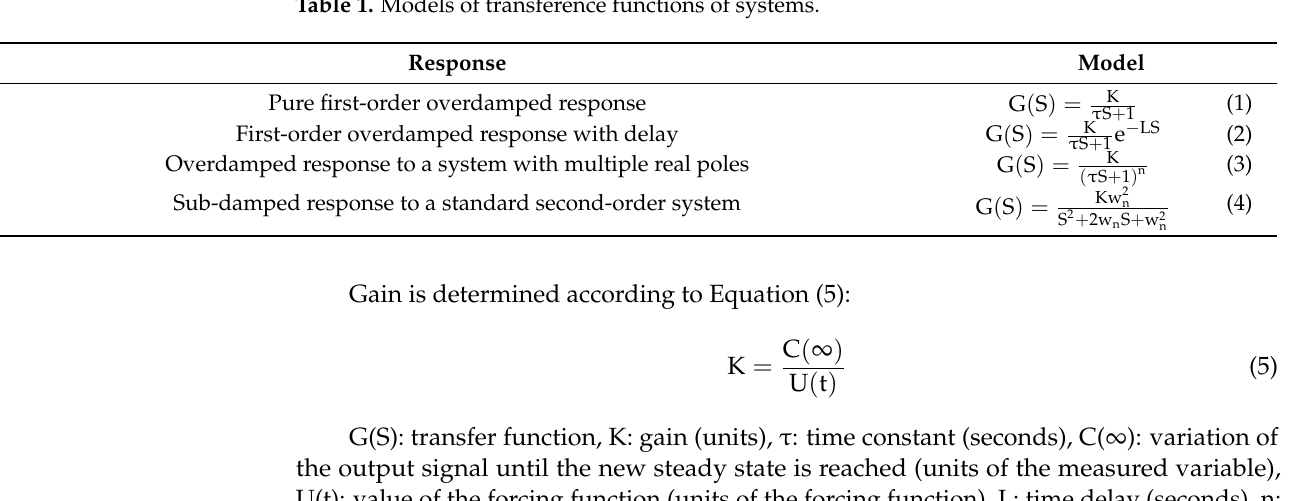
Table 1. Models of transference functions of